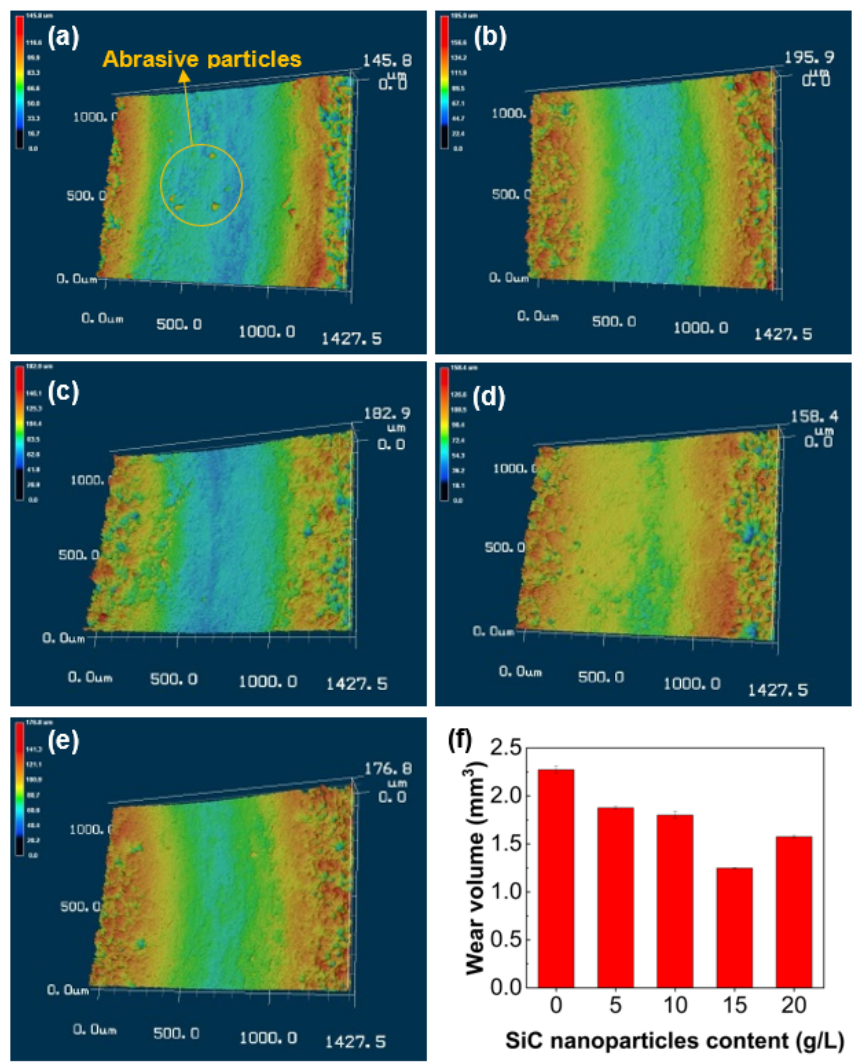
Figure 11. 3D morphologies and wear volume of CPED coatings: ( a – e ) wear tracks of samples S0, S5, S10, S15 and S20; ( f ) wear volume for coatings.